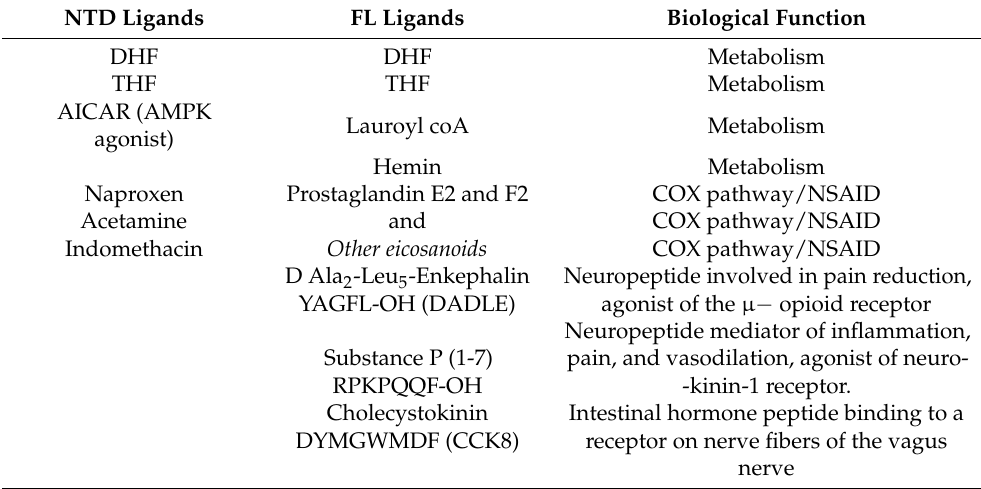
Table 1. NTD and FL ligands identified by virtual screening and their reported biological functions.